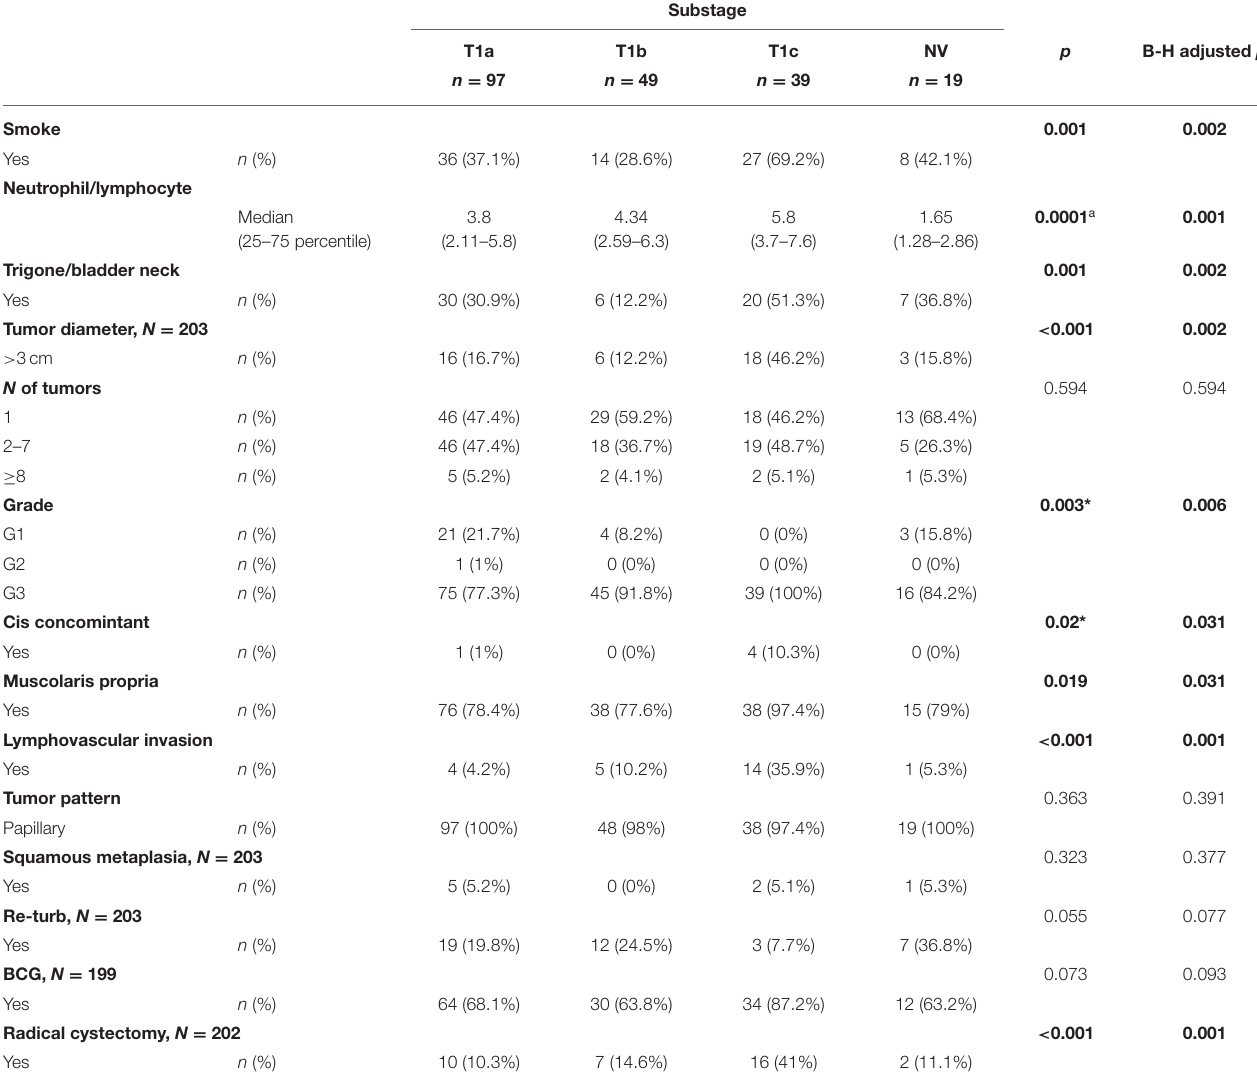
TABLE 3 | Association between Subcategory T1a-c and other